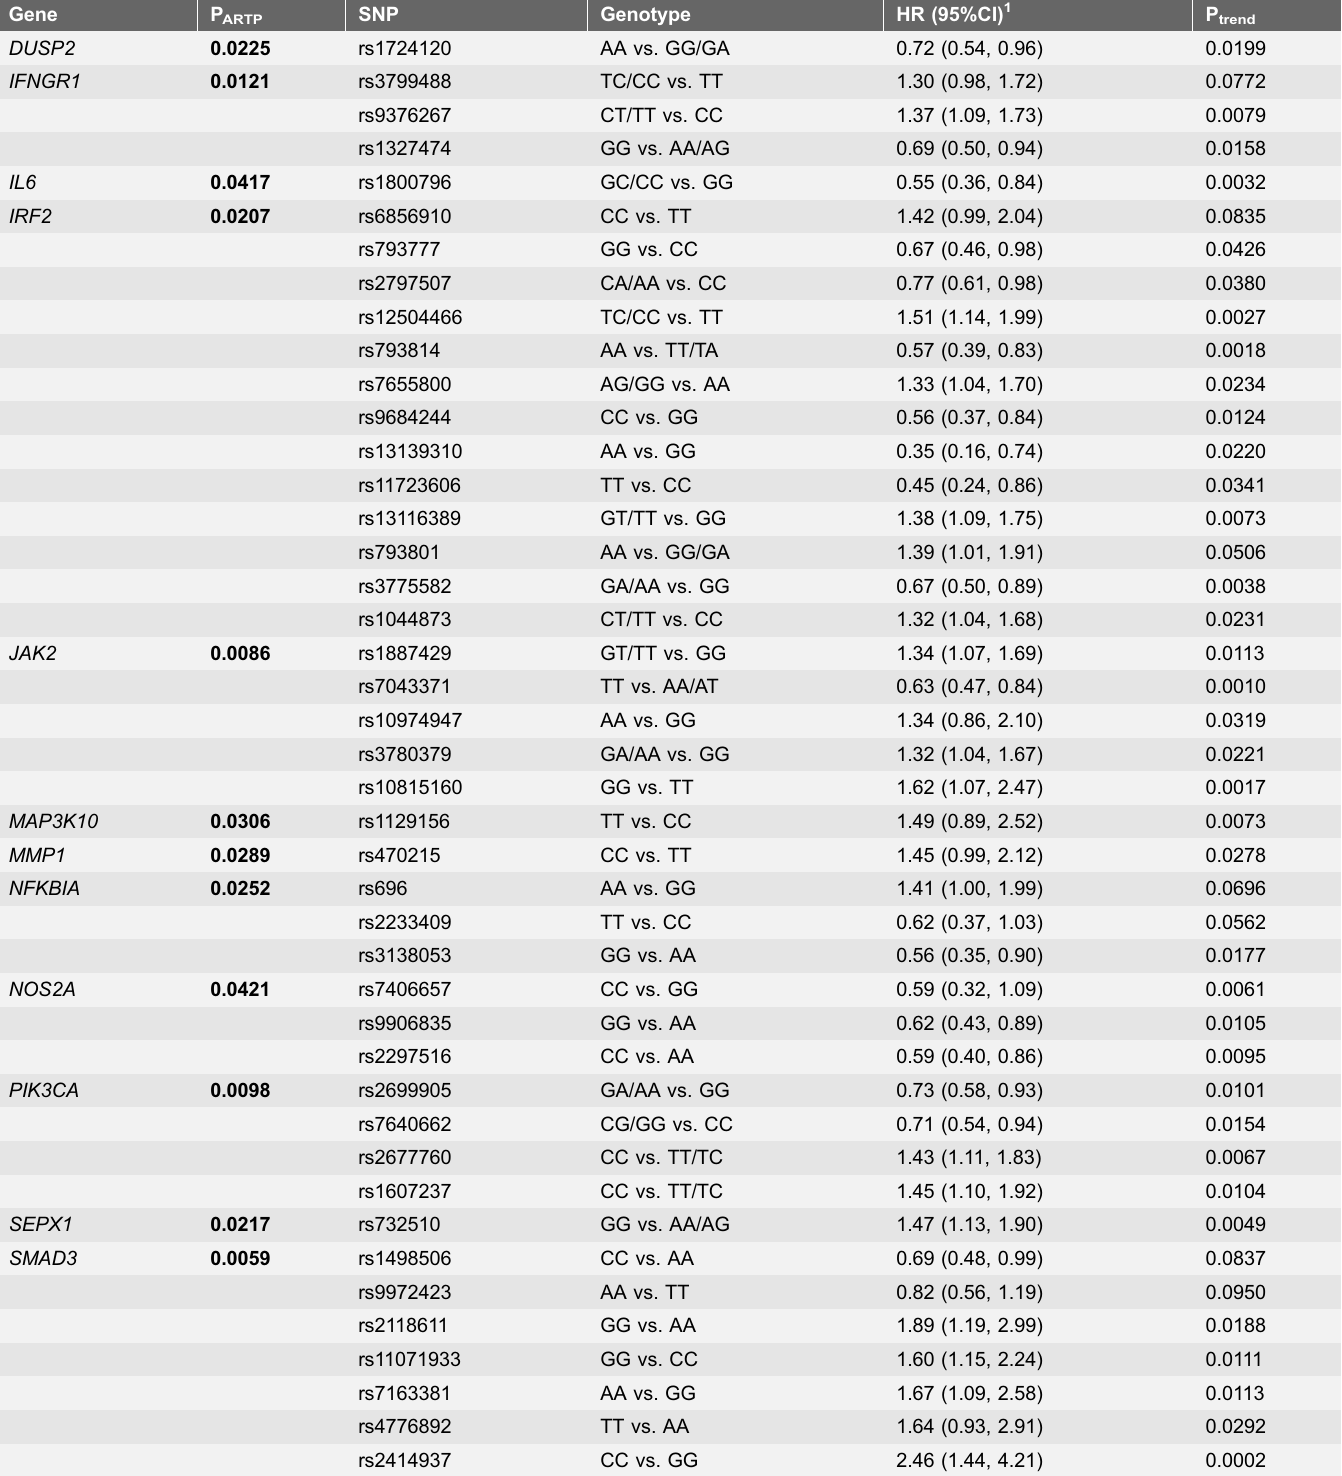
Table 3. Genes and related SNPs associated with colorectal cancer-specific mortality among patients diagnosed with colon cancer (gene P ARTP # 0.05; SNP P trend #